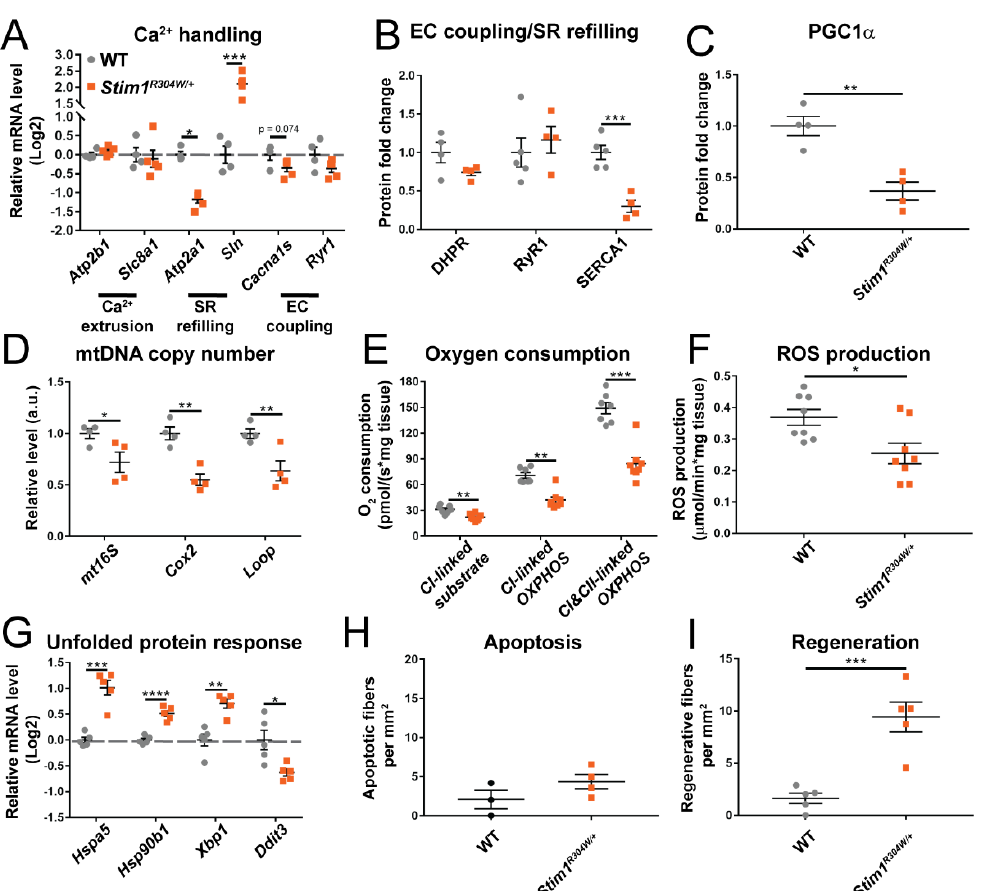
Figure 5. Defective Ca 2+ handling, reduced mitochondrial copy number, and increased reticular stress in Stim1 R304W/+ slow-twitch muscle. ( A , B ) RT-qPCR on selected genes illustrates a reduction of SERCA1 gene expression and protein level and a simultaneous upregulation of the SERCA1 inhibitor Sln in Stim1 R304W/+ soleus, while other genes involved in Ca 2+ handling are normally expressed ( n = 4–5). ( C , D ) In agreement with the reduced protein level of the mitochondrial biogenesis regulator PGC1 α in Stim1 R304W/+ soleus, the mitochondrial copy number marker genes mt16s , Cox2 , and Loop are decreased compared with the WT ( n = 4). ( E , F ) Oxygen consumption and ROS production are significantly lower in Stim1 R304W/+ compared with WT soleus ( n = 7–8). ( G ) Increased UPR in Stim1 R304W/+ soleus as illustrated by the upregulation of the stress-regulated genes Hspa5 , Hsp90b1 , and Xbp1 ( n = 4–5). ( H , I ) Stim1 R304W/+ soleus sections show a tendency of augmented apoptosis and a significant increase of regenerating fibers compared with controls ( n = 3-5). Significant differences are illustrated as * ( p < 0.05), ** ( p < 0.01), *** ( p < 0.001), and **** ( p < 0.0001).